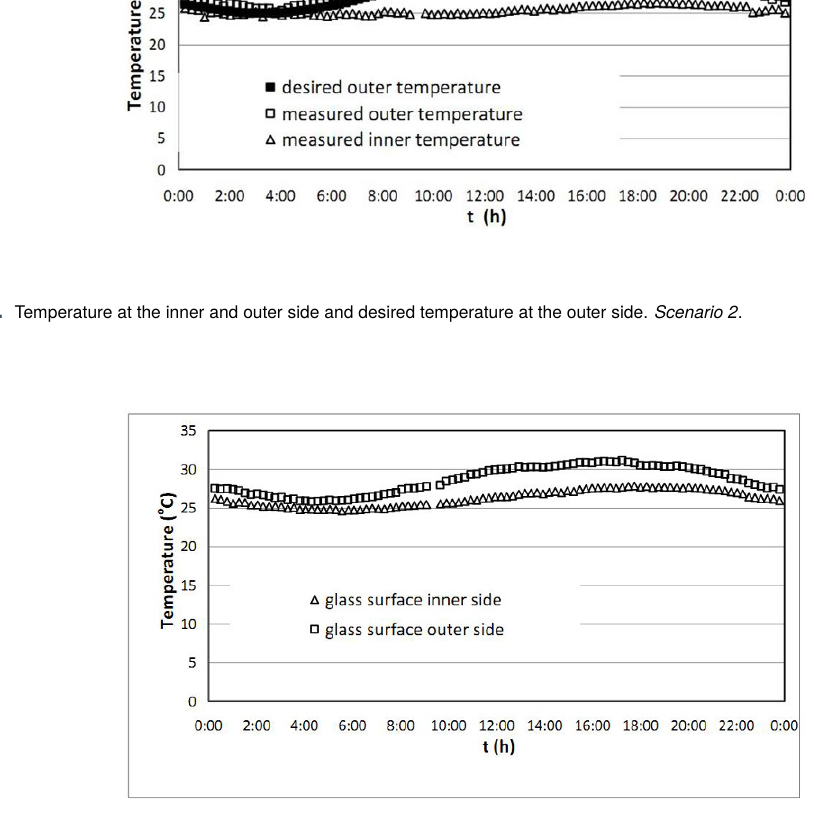
Figure 13. Measured temperature at the external triple glazing surfaces at the inner and outer side. Scenario 2